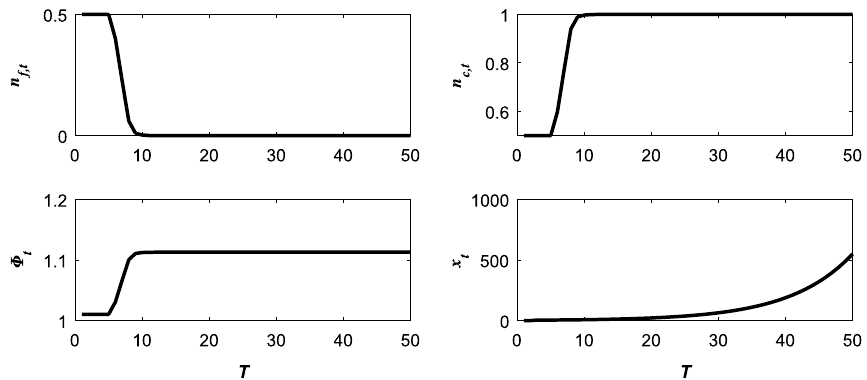
Fig. 8 Dynamic response to a positive shock based on HAM2: x t = 1 R ∗ ( 0.908 n f , t + 1.113 n c , t ) x t − 1 + ǫ t , ǫ t ∼ N ( 0,0.048